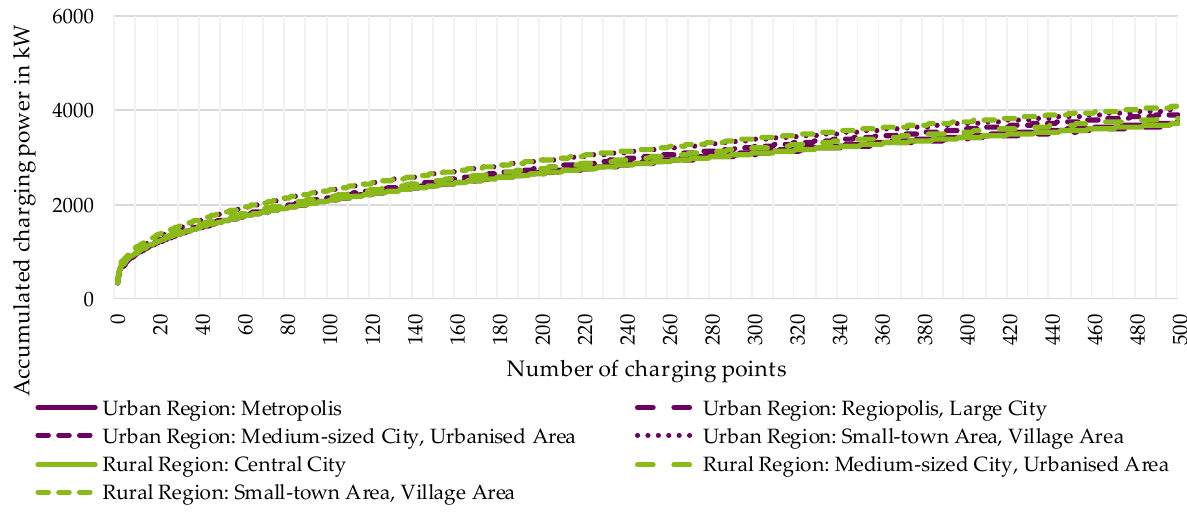
Figure A7. Accumulated charging power in kW for 350 kW charging points up to 500 charging points for seven area types.